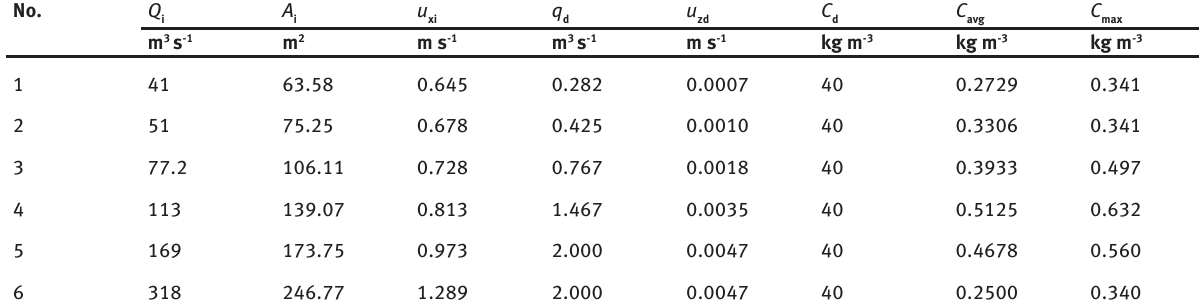
Table 4: Input data and